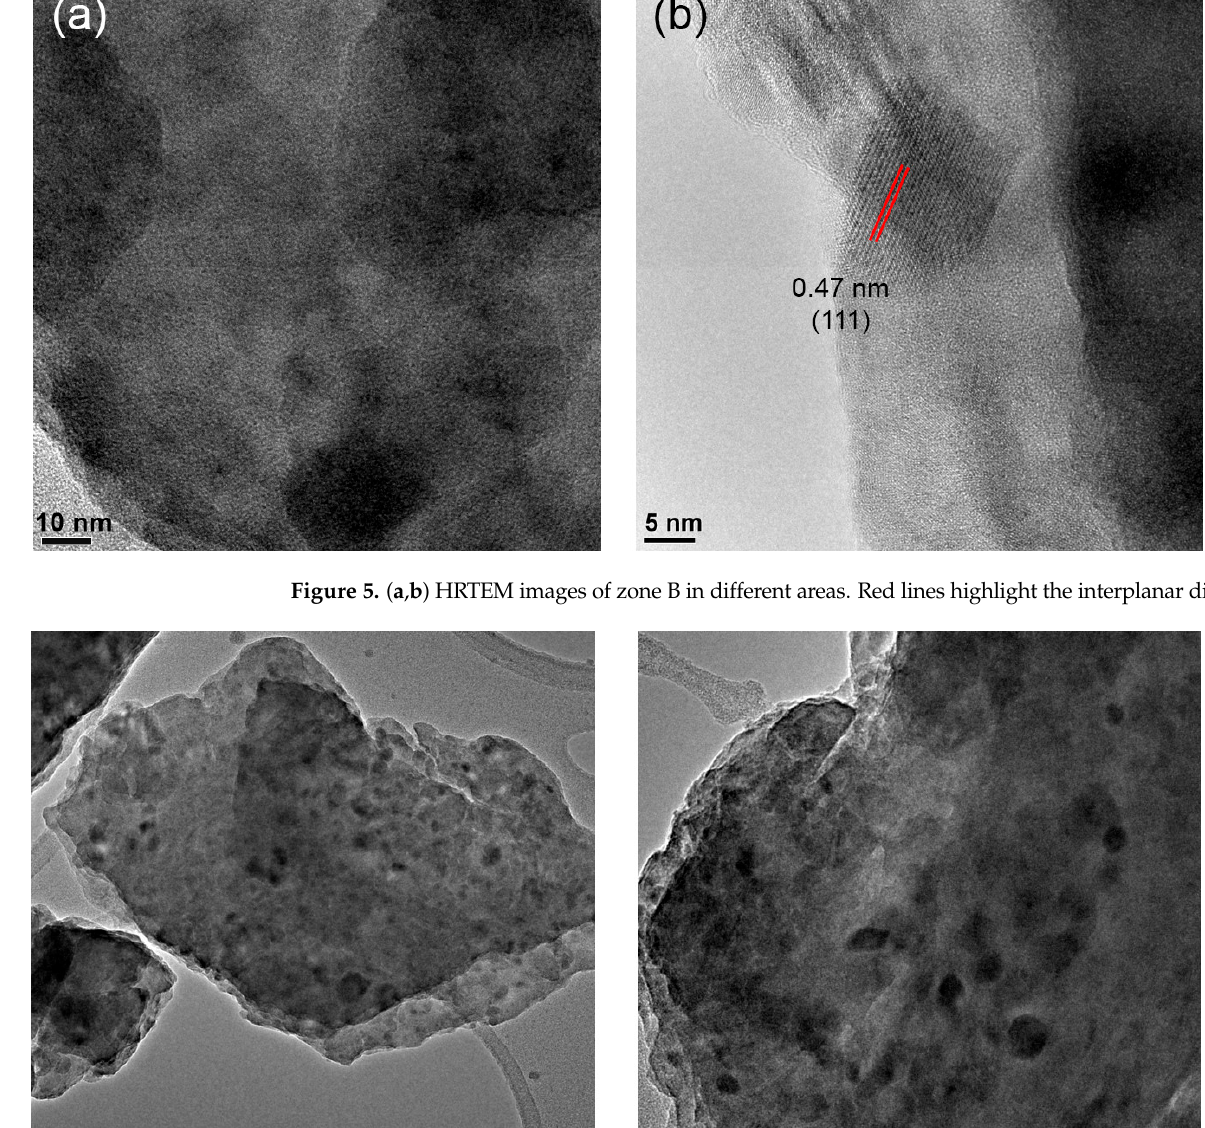
Figure 5. ( a , b ) HRTEM images of zone B in di ff erent areas. Red lines highlight the interplanar dis- tance.